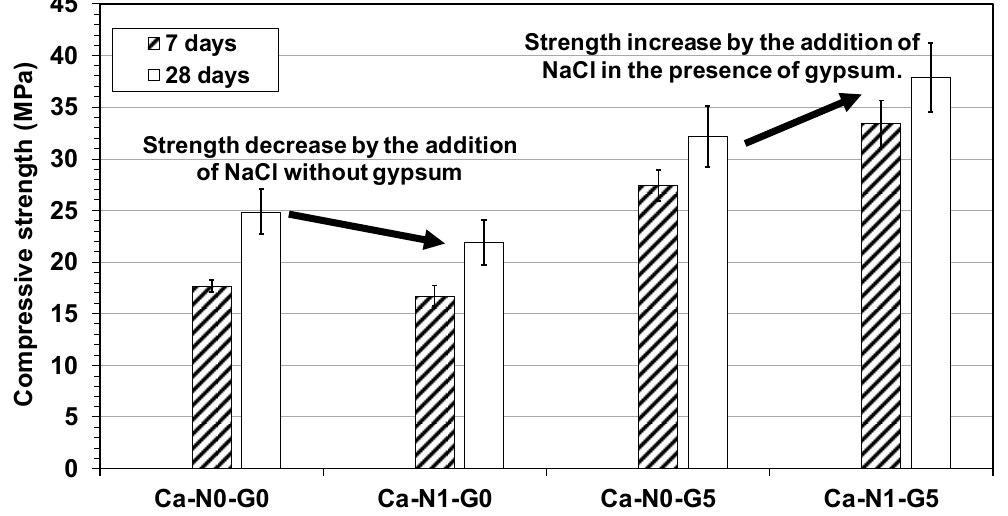
Figure 2. Compressive strengths of hardened paste samples. The error bars indicate standard deviations.